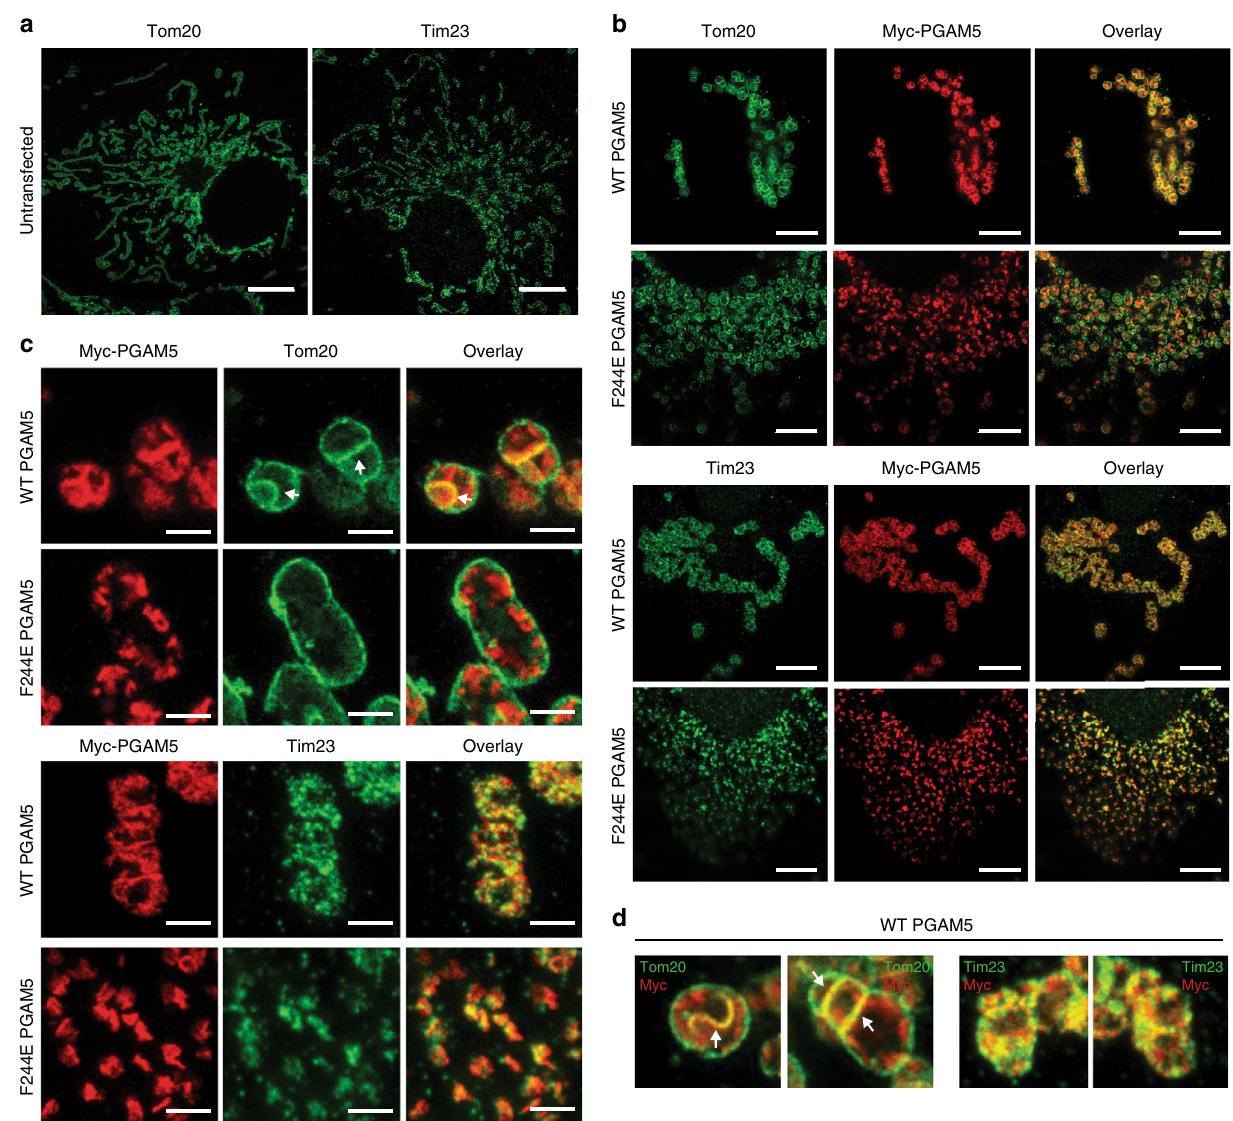
Fig. 8 PGAM5 localizes at inner mitochondrial membrane and at the membrane contact sites. a – d STED images of COS7 cells that were either a untransfected or b , c transiently transfected with wild type (WT) or F244E full-length myc-tagged PGAM5. Tom20 was visualized with anti-Tom20 antibody (green), Tim23 with anti-Tim23 antibody (green), and PGAM5 with anti-myc antibody (red). White arrows indicate contact sites between mitochondrial membranes in which myc-tagged PGAM5 was found colocalized with Tom20. Scale bars correspond to 5 µ m in a , 5 µ m in b , and 1 µ m in c . d Upper panels show representative close-up views of PGAM5 localization to the sites of mitochondrial membrane contacts. White arrows indicate sites of PGAM5 (myc, red) overlap with the outer mitochondria membrane marker Tom20